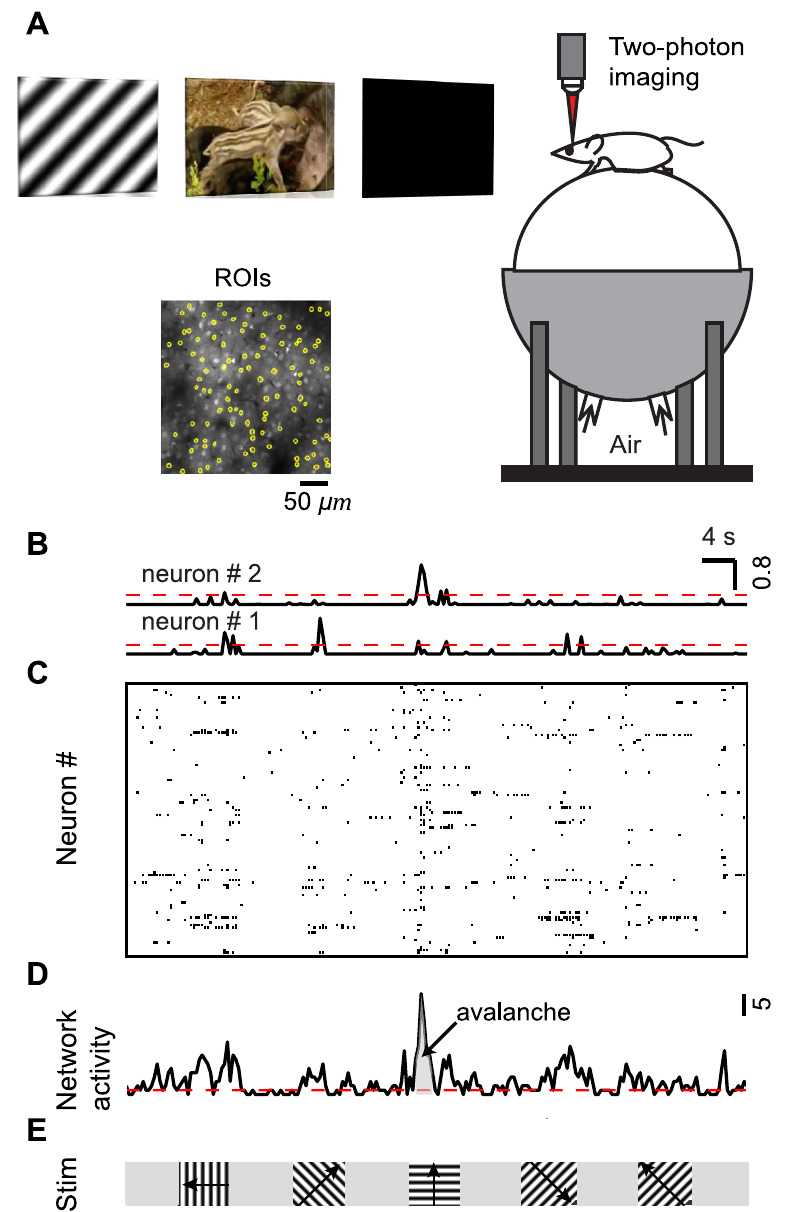
Fig 2. Quantifying the level of coordination at cellular resolution within cortical microcircuits of behaving mice. (A) Illustration of population Ca imagingfrom the visual cortex in a head-fixedawake mouse on a sphericaltreadmill duringviewingof three types of visual stimuli: square or sine wave grating, natural movie, and dark screen. For clarity, the head fixation was omitted from the drawing. Inset: Two-photon microscopic image of a typical field of view from neuronsbolus-loaded with Oregon Green Bapta-1 AM (OGB- 1) dye in layer 2/3 of V1. Regionsof interest (ROIs, yellow) are overlaidon the image. (B) Inferred spike probabilityfor two representative neuronsduringvisual stimulationwith sine-wavegratings (see (E)). Spike probabilitywas inferred from calcium sensitive dye fluorescentsignals using a spike inference algorithm (Methods). Spike probabilitywas then thresholded(dashedred line) to a level of 3 SDs above 0, and convertedto 1 (active) or 0 (inactive). (C) Raster plot of activity (movinggratings) constructed using the thresholded spike probability. Each row represents a singleneuron, and each mark represents the inferred spikingactivity of that neuron, i.e., the thresholded spike probabilitywith value 1 (active). (D) “Network activity” (black) is the sum of all spikingneuronsin a time bin (250 ms), i.e., the thresholdedinferred spike probability summed over all recordedneuronsin that time bin. A threshold (dashedred line) at median network activity definedthe start and end of a “neuronalavalanche” as the time points of crossing this threshold.